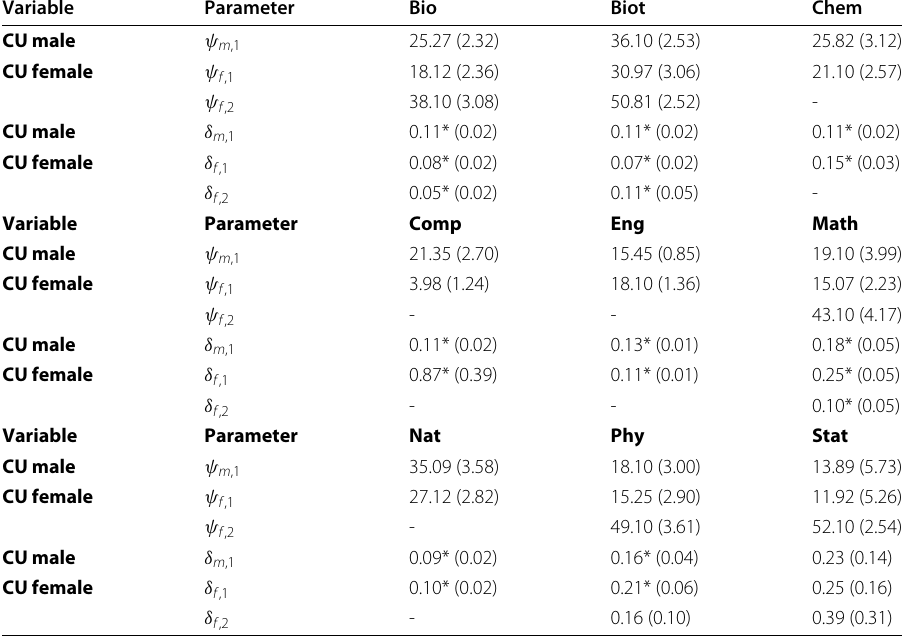
Table 8 Parameter estimates of the ψ ’s and δ ’s of the segmented regression models by courses Variable